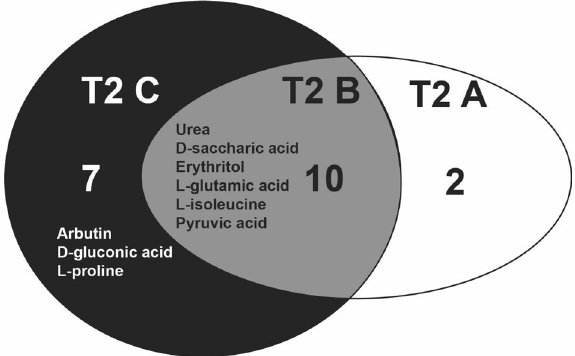
Figure 5. Unique root exudate compounds were detected within each treatment A (control), B (mild), and C (severe) at T2 (after treatment) using GC–MS. In total, 19 identified and non-identified metabolites were observed in treatments A, B, and C at T2 only (not at T1 (before treatment)). Identified metabolites unique to each treatment are listed while unidentified compounds are not listed (e.g. two compounds for A were not listed because they were not identified). Treatment B shared 10 compounds (6 identified and listed) with treatments A and C. Venn diagram of all (identified and unidentified) GC–MS metabolites found at T2 (including compounds from T1) are presented in Fig. S9.